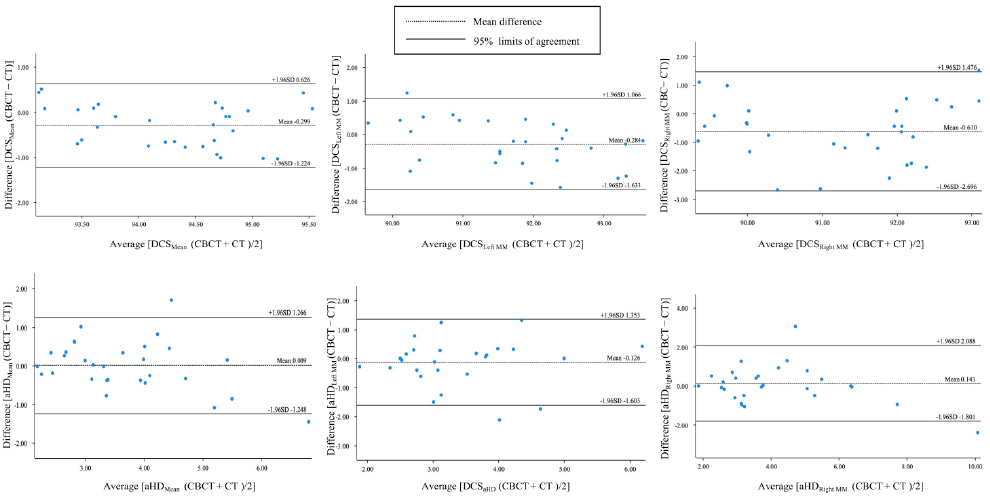
Figure 6. The Bland–Altman plots for agreement analysis between auto-segmentation results on CBCT and CT by the Dice similarity coefficient (DSC) and average Hausdorff distance (aHD).